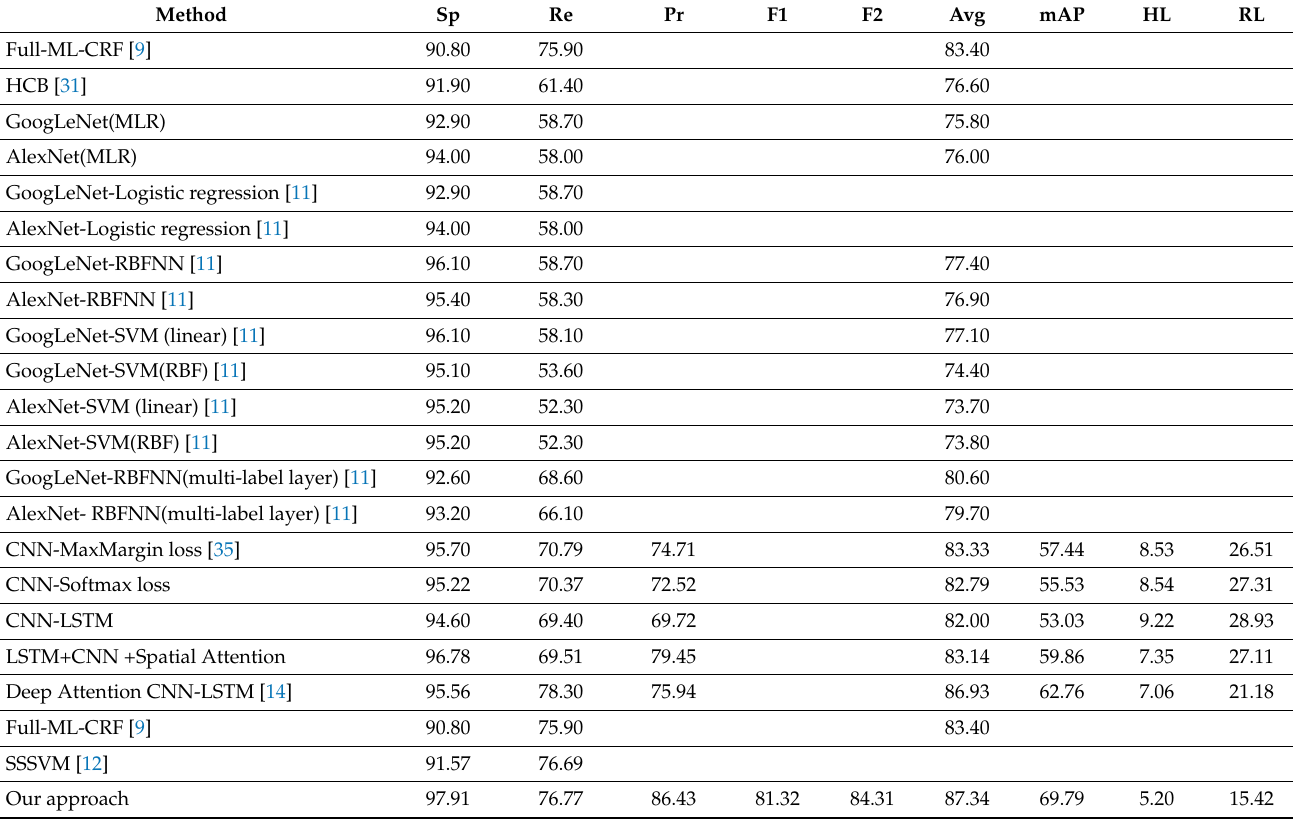
Table 7. Results of the Civezzano multi-label